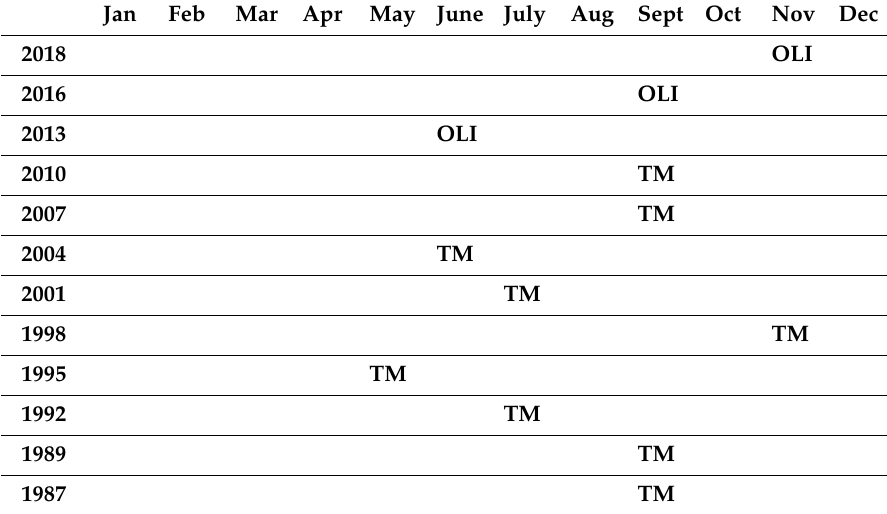
Table 1. The Landsat TM/OLI data from 1987 to 2018.